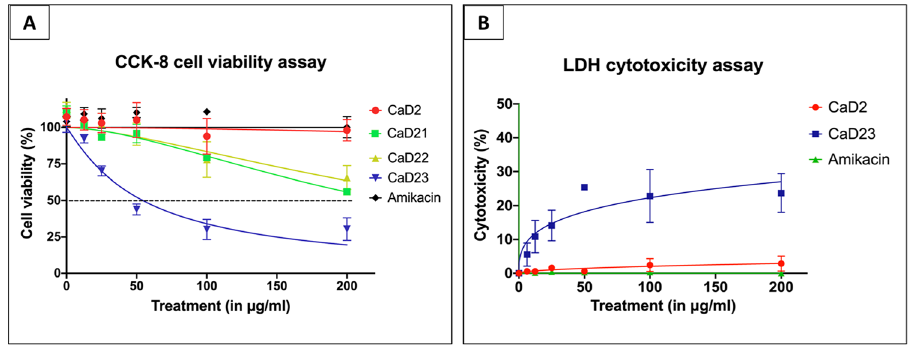
Figure 1. Cytotoxicity of synthetic peptides and amikacin (a commonly used antibiotic for bacterial keratitis) in various concentrations against human corneal epithelial cells (HCE-2), presented as dose–response curves (normalized, variable slope). Percentage cell viability is presented as mean ± standard deviation (depicted in error bars) of two independent experiments performed in biological duplicate. Some error bars are missing due to small standard deviation values. ( A ) Cell viability assay (using cell counting kit-8 assay) demonstrating normal metabolic activity of epithelial cells in CaD2 and amikacin but reduced activity in CaD23 (IC 50 = 54.6 ± 11.7 μg/ml) after 3 h of treatment. IC 50 (concentration of treatment inhibiting 50% of cell viability) is shown in a black dotted line. ( B ) Cytotoxicity assay (using lactate dehydrogenase assay) demonstrating no sign of cytotoxicity of epithelial cells in amikacin and CaD2, and low level of cytotoxicity in CaD23 (30.4 ± 7.8% at 200 μg/ml; LC 50 > 200 μg/ml) after 3 h of treatment.